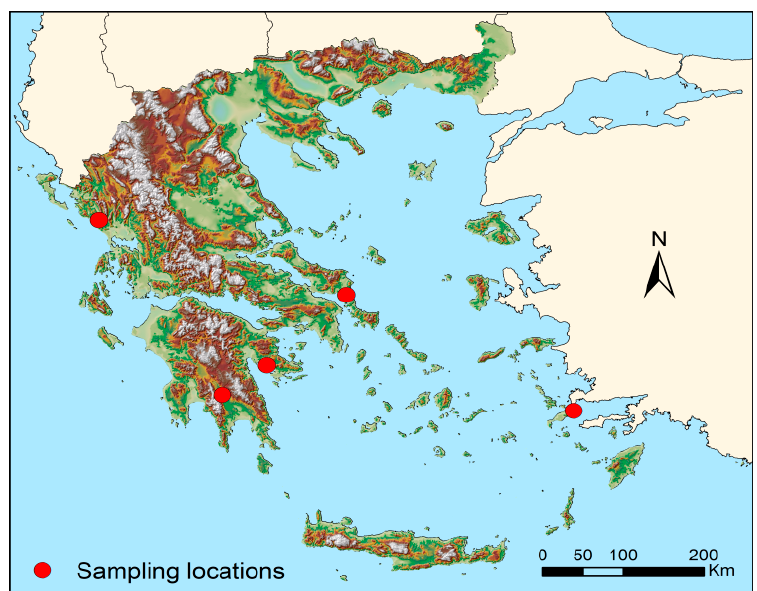
Figure 1. The sampling locations as shown in the map.